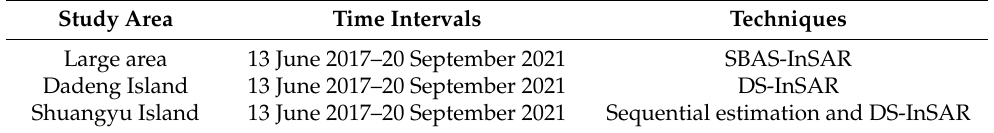
Table 1. SAR data coverage and techniques involved in different